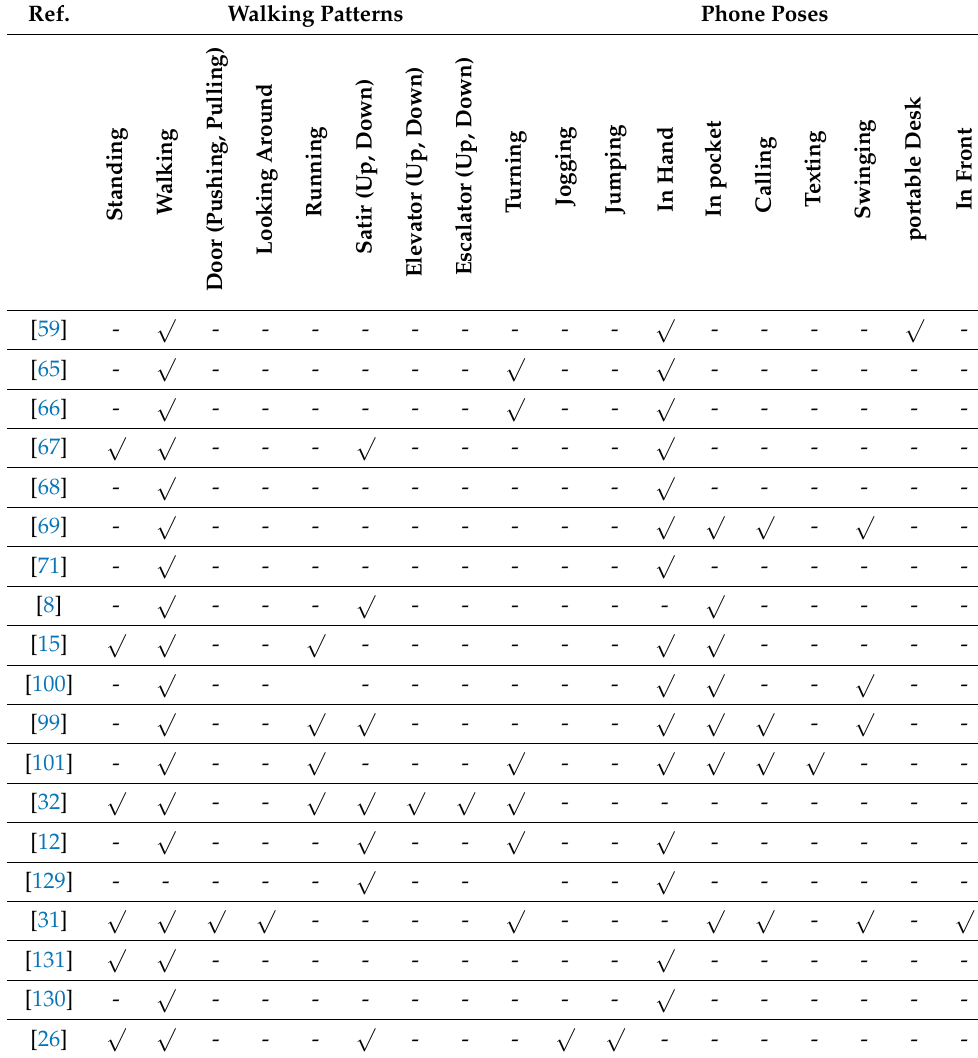
Table 5. Walking patterns and phone